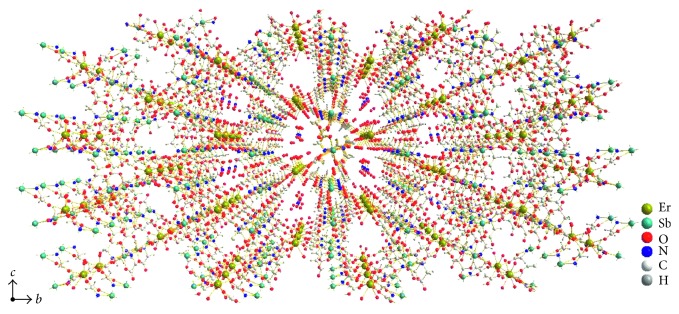
Packing diagram of the title complex viewed along the a axis.